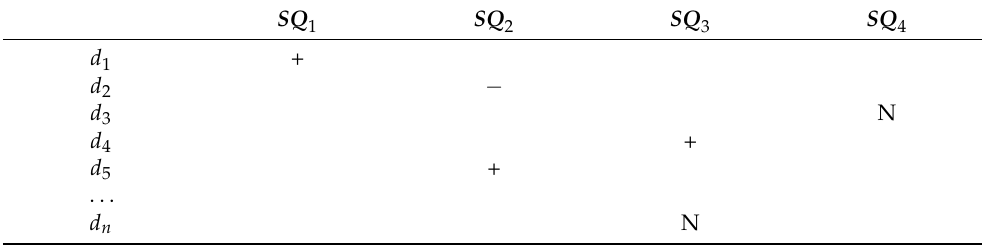
Table 2. Example of SO assigned to SQ